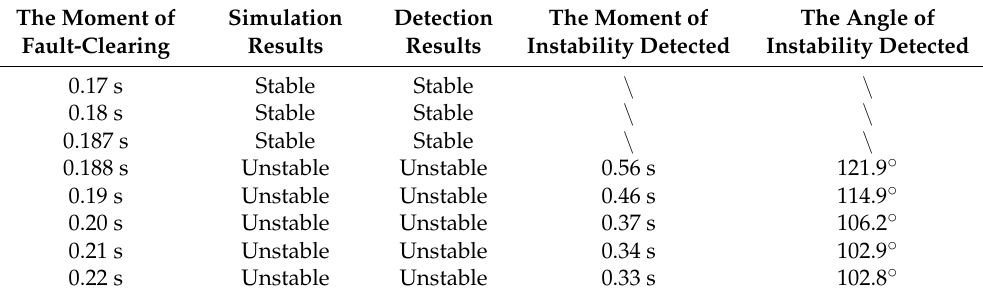
Table 2. The transient stability detection results by 100 Hz sample